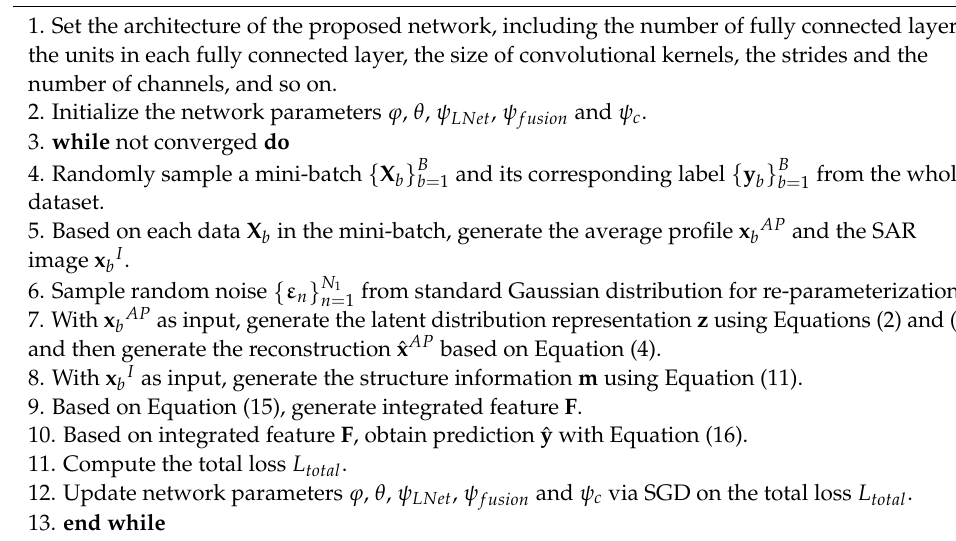
Algorithm 1. Training Procedure of the Proposed Network